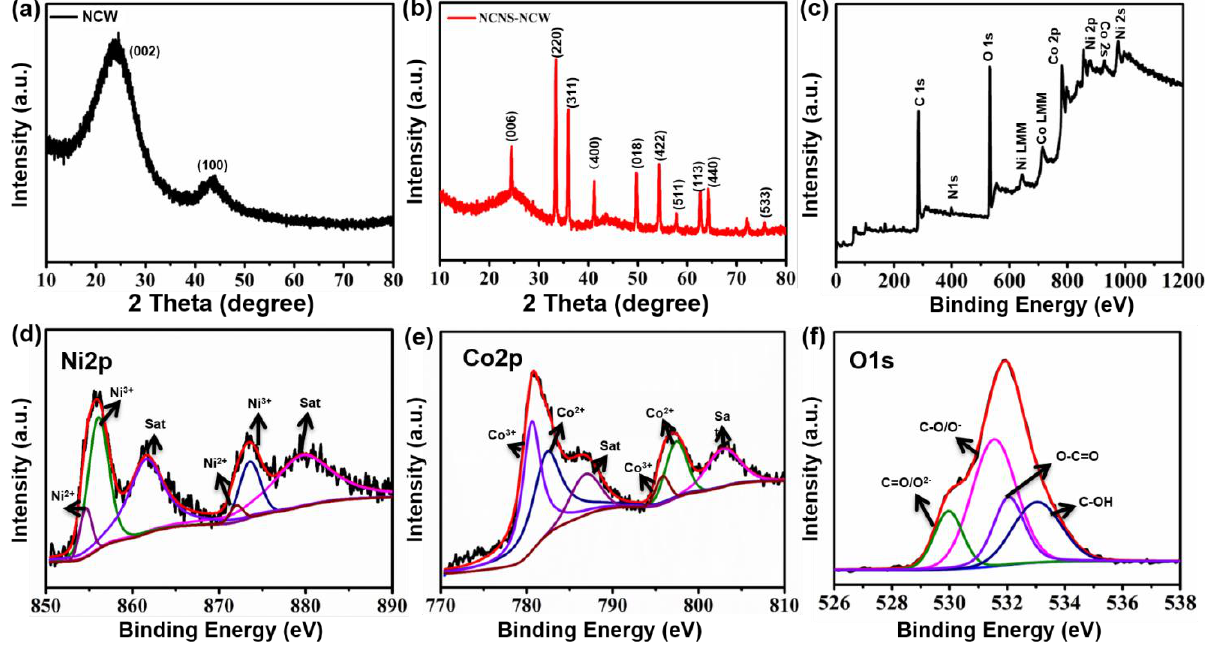
Figure 2. ( a ) XRD patterns of NCW and NCNS − NCW. ( b ) XPS of NCNS − NCW. ( c ) Survey scan, ( d ) Ni 2p, ( e ) Co 2p, ( f ) O 1s of the sample.